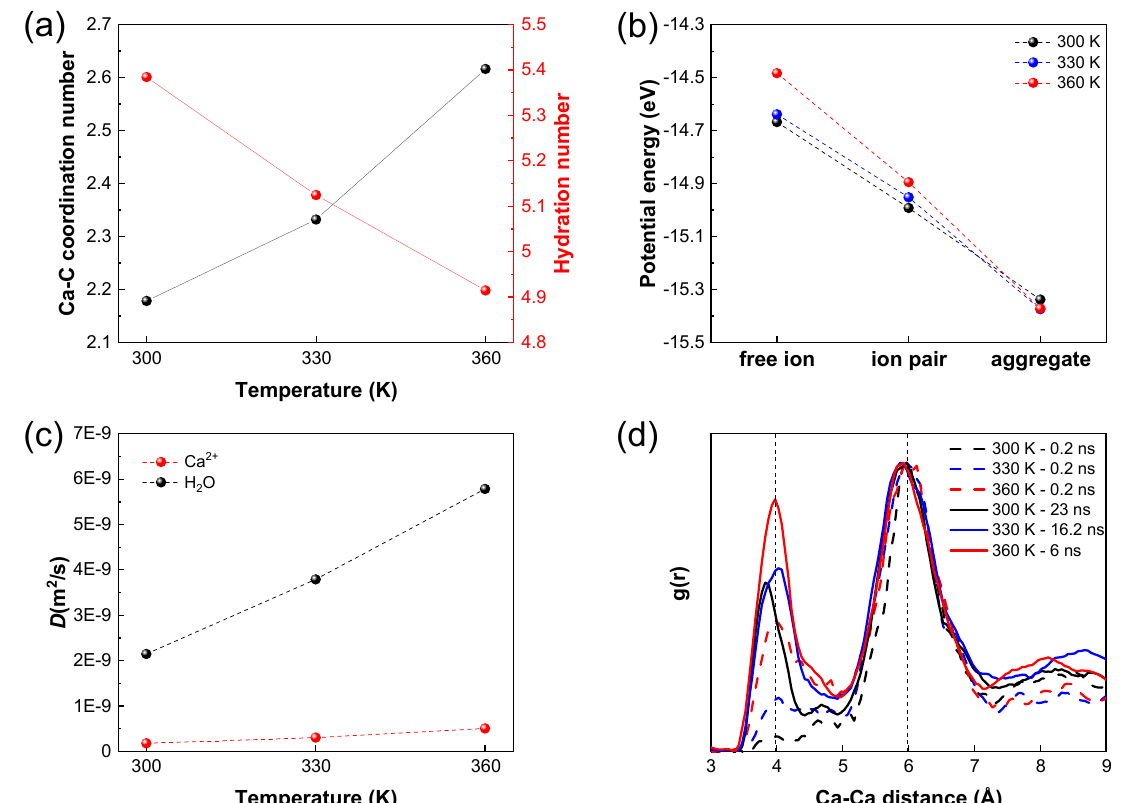
Figure 6. Influence of temperature (300, 330, and 360 K) on nucleation for 0.72 mol/L supersaturated CaCO 3 solution. ( a ) Ca-C coordination number and hydration number of aggregate. ( b ) Potential energy of Ca 2+ with different forms. ( c ) Diffusion coefficient for water and Ca 2+ . ( d ) Radial distribution function of Ca-Ca distance ( g Ca-Ca ) before and after nucleation. Note that the absolute magnitude of g Ca-Ca has been scaled through normalization